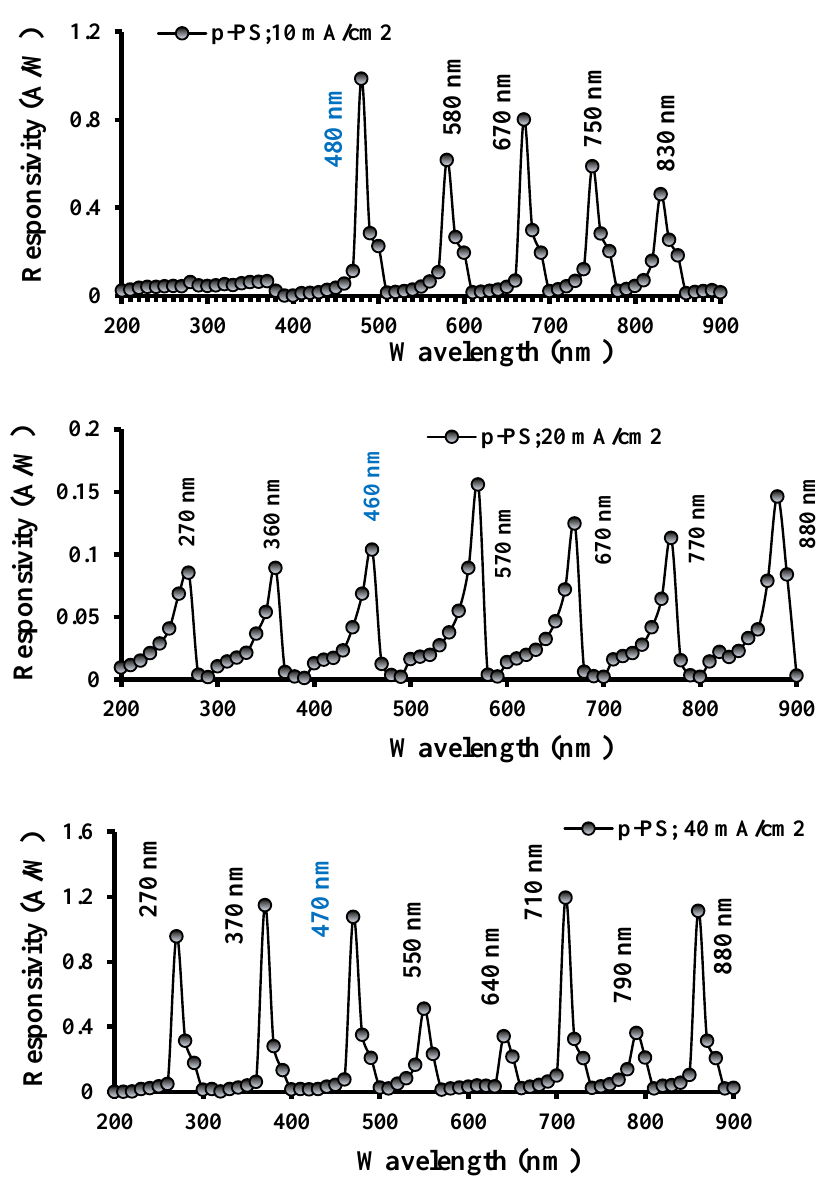
Fig.8: The variation of spectral responsivity of p-PS as a function of the wavelength at different anodization current densities of (10, 20 and 40) mA/cm 2 at zero bias voltage